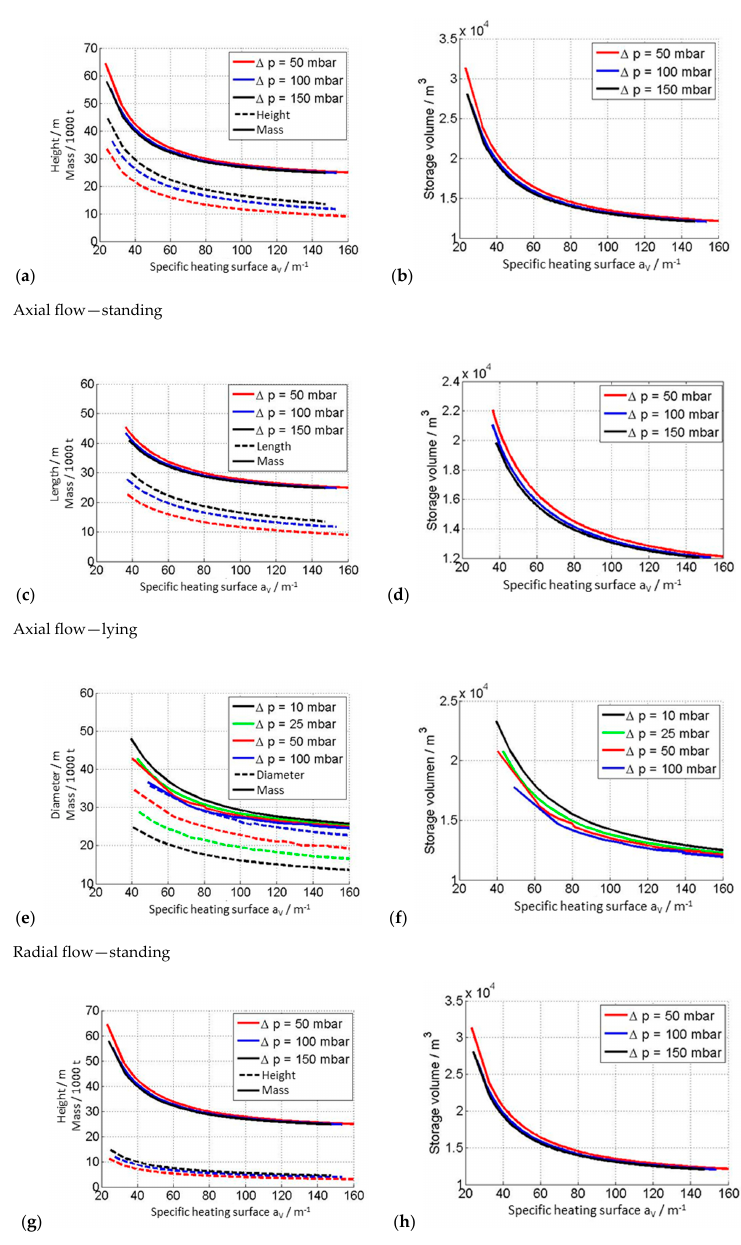
Figure 6. Inventory mass, storage height and volume in accordance with pressure drop and specific heating surface: ( a ) Axial flow—standing: Required inventory mass and storage height depending on the specific heating surface for di ff erent maximum pressure losses along the storage bed, ( b ) Axial flow—standing: Storage volume depending on the specific heating surface for di ff erent maximum pressure losses along the storage bed, ( c ) Axial flow—lying: Required inventory mass and storage length depending on the specific heating surface for di ff erent maximum pressure losses along the storage bed, ( d ) Axial flow—lying: Storage volume depending on the specific heating surface for di ff erent maximum pressure losses along the storage bed, ( e ) Radial flow—standing: Required inventory mass and storage diameter depending on the specific heating surface for di ff erent maximum pressure losses along the storage bed, ( f ) Radial flow—standing: Storage volume depending on the specific heating surface for di ff erent maximum pressure losses along the storage bed, ( g ) Meander-shaped flow—standing: Required inventory mass and storage height depending on the specific heating surface for di ff erent maximum pressure losses along the storage bed, ( h ) Meander-shaped flow—standing: Storage volume depending on the specific heating surface for di ff erent maximum pressure losses along the storage